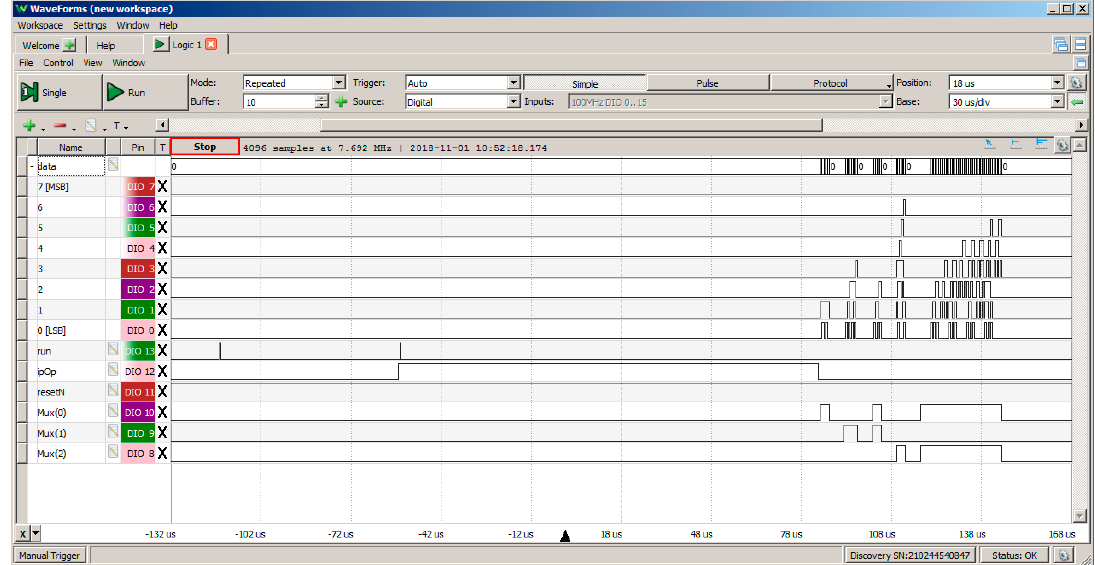
Figure 15. Logic analyzer test results using the Digilent ® Analog Discovery: Complete cycle.